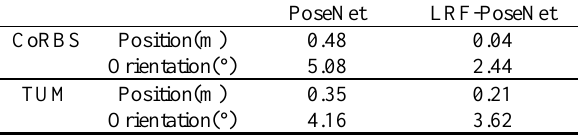
Table 1 . Comparison table of average accuracy. Figure 6 is a scatter plot of the position and orientation errors of the query image after using two methods on the TUM data. The horizontal axis is the position error, in meters, and the vertical axis is the direction error, in degrees. Figure 6a is the result of PoseNet running, and Figure 6b is the result of LRF-PoseNet running. It can be seen from the figure that the error point of the improved method in this paper is closer to the origin point, that is, the position error and the orientation error are smaller, which shows that the method in this paper has significantly improved the accuracy of the PoseNet method. Especially for some points difficult in positioning, the PoseNet method has more points with larger positioning error, and its position error and orientation error can reach about 1.5m and 15 degrees, respectively. For LRF-PoseNet, the maximum position error and orientation error are about 0.7m and 12 degrees respectively, and the number of such points is very small. That is the position accuracy and orientation accuracy are greatly improved compared with PoseNet.